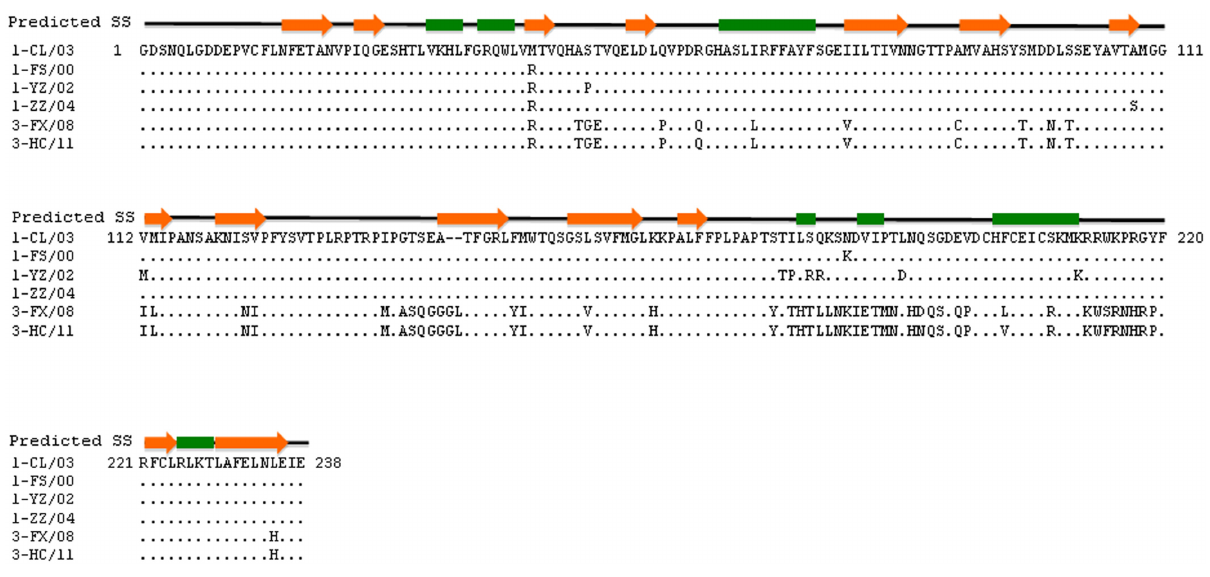
Fig 4. Sequence alignment and predicted secondary structure of VP1 protein of DHAV-1 and DHVA-3 viruses. Orange arrows are β strands while green rectangles are α helices. DHAV-1 strain 1-CL/03 is used here as a reference strain for development of a secondary structure model of VP1.